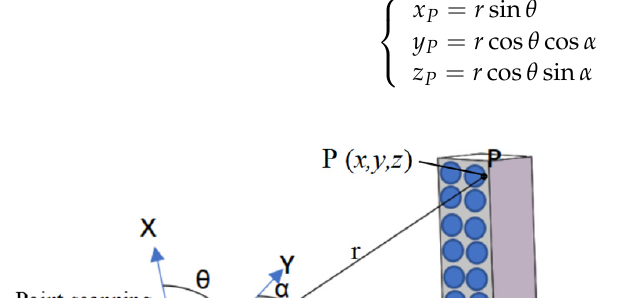
Figure 1. Schematic diagram of mechanism of single-point laser scanning measurement in spherical coordinate.